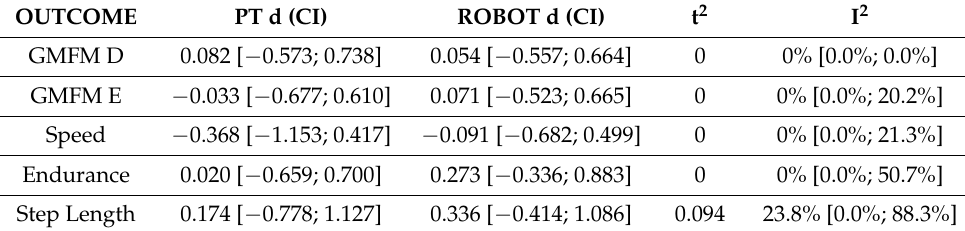
Table 4. Results for components.